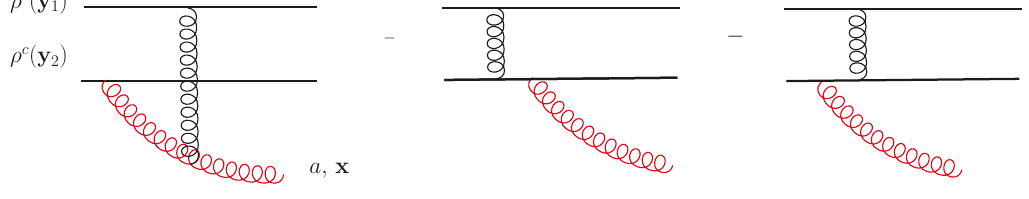
( x ) produced at transverse position x by two color P and y 1 2